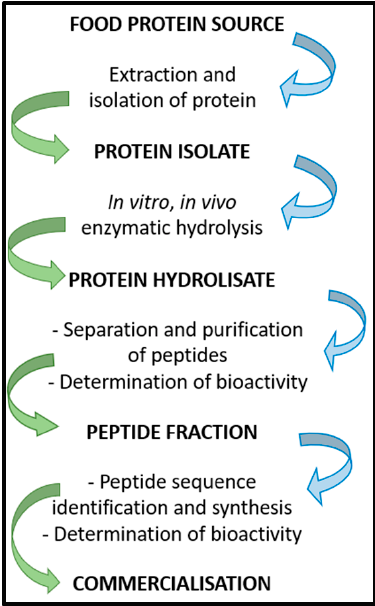
Figure 1. Scheme of BP isolation, preparation, and commercialization.